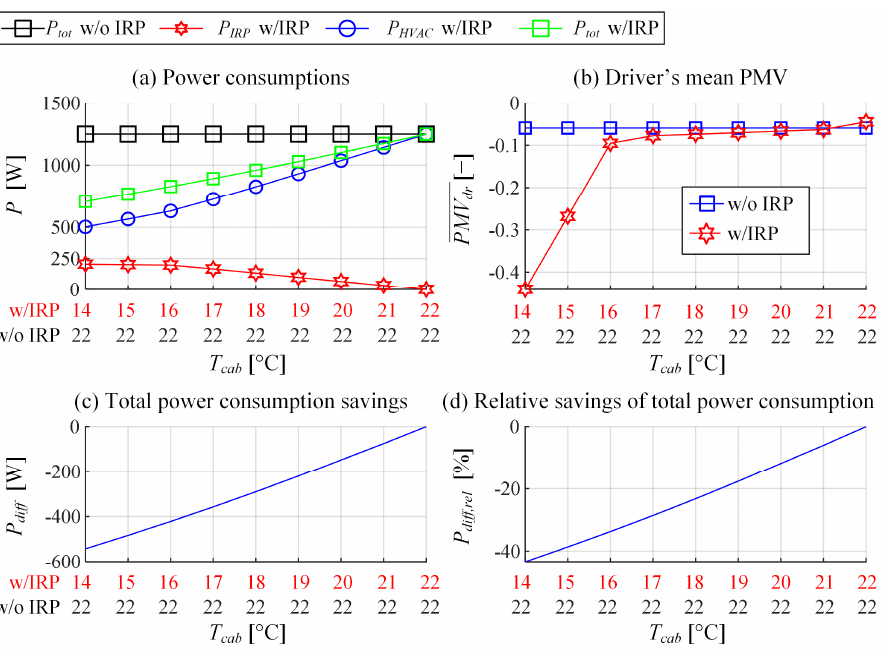
Figure 12. Simulation results of HVAC-only and HVAC+IRP systems for scenario of increasing cabin air temperature target difference.